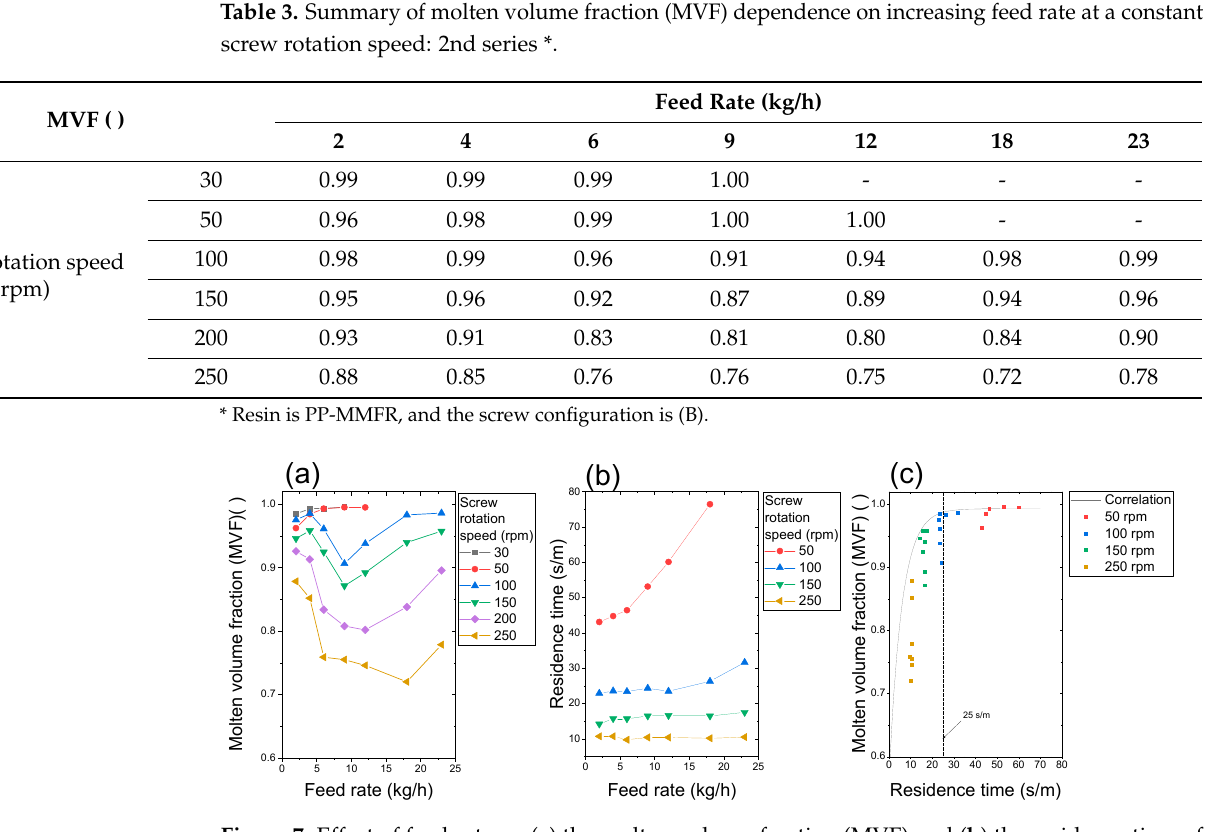
Figure 7. Effect of feed rate on ( a ) the molten volume fraction (MVF) and ( b ) the residence time of pellets. The residence time was measured for the solid pellets at 30 °C. The screw configuration was (B). ( c ) Relationship between the MVF and the residence time per meter. The correlation line was drawn using the parameters and Equation (3).